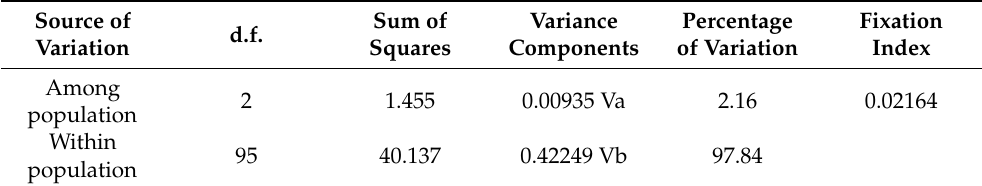
Table 2. Analysis of molecular variance (AMOVA) results for blue sharks.